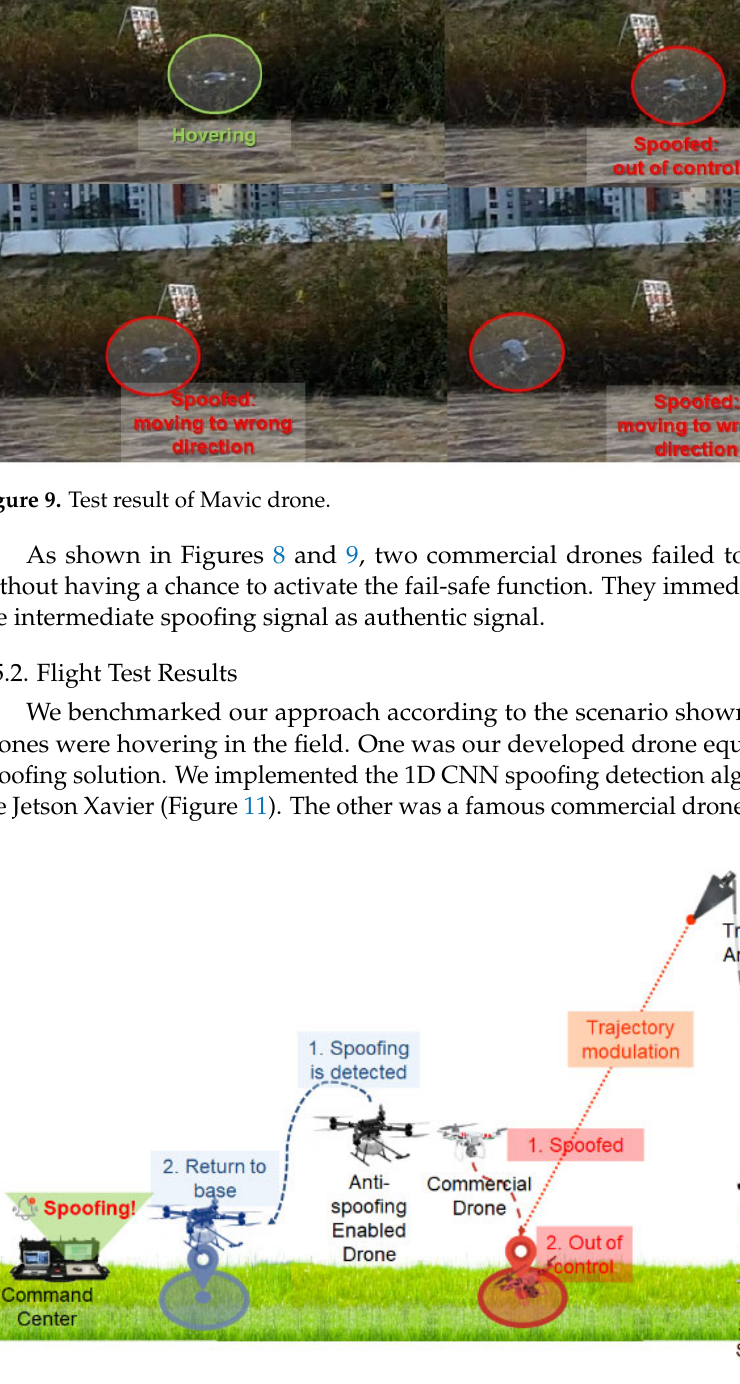
Figure 10. Spoofing test scenario.